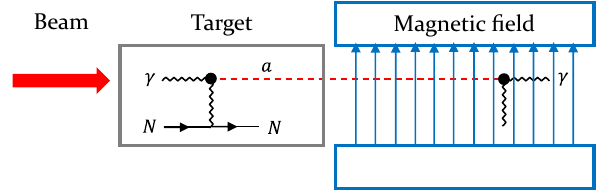
Fig. 1 Schematic description of the PASSAT search strategy under consideration